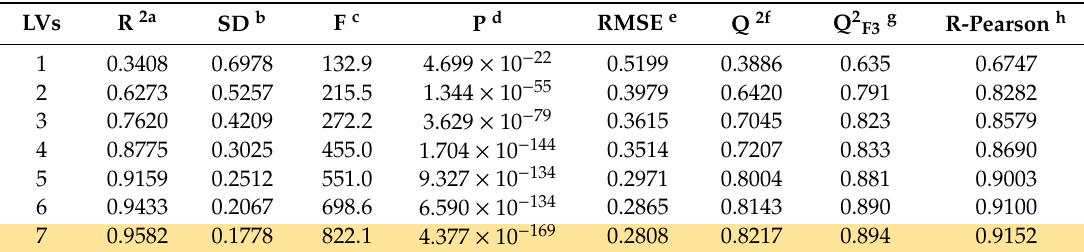
Table 2. 3D-QSAR statistical parameters of the seven Latent Variables (LVs) Phase-derived sets of